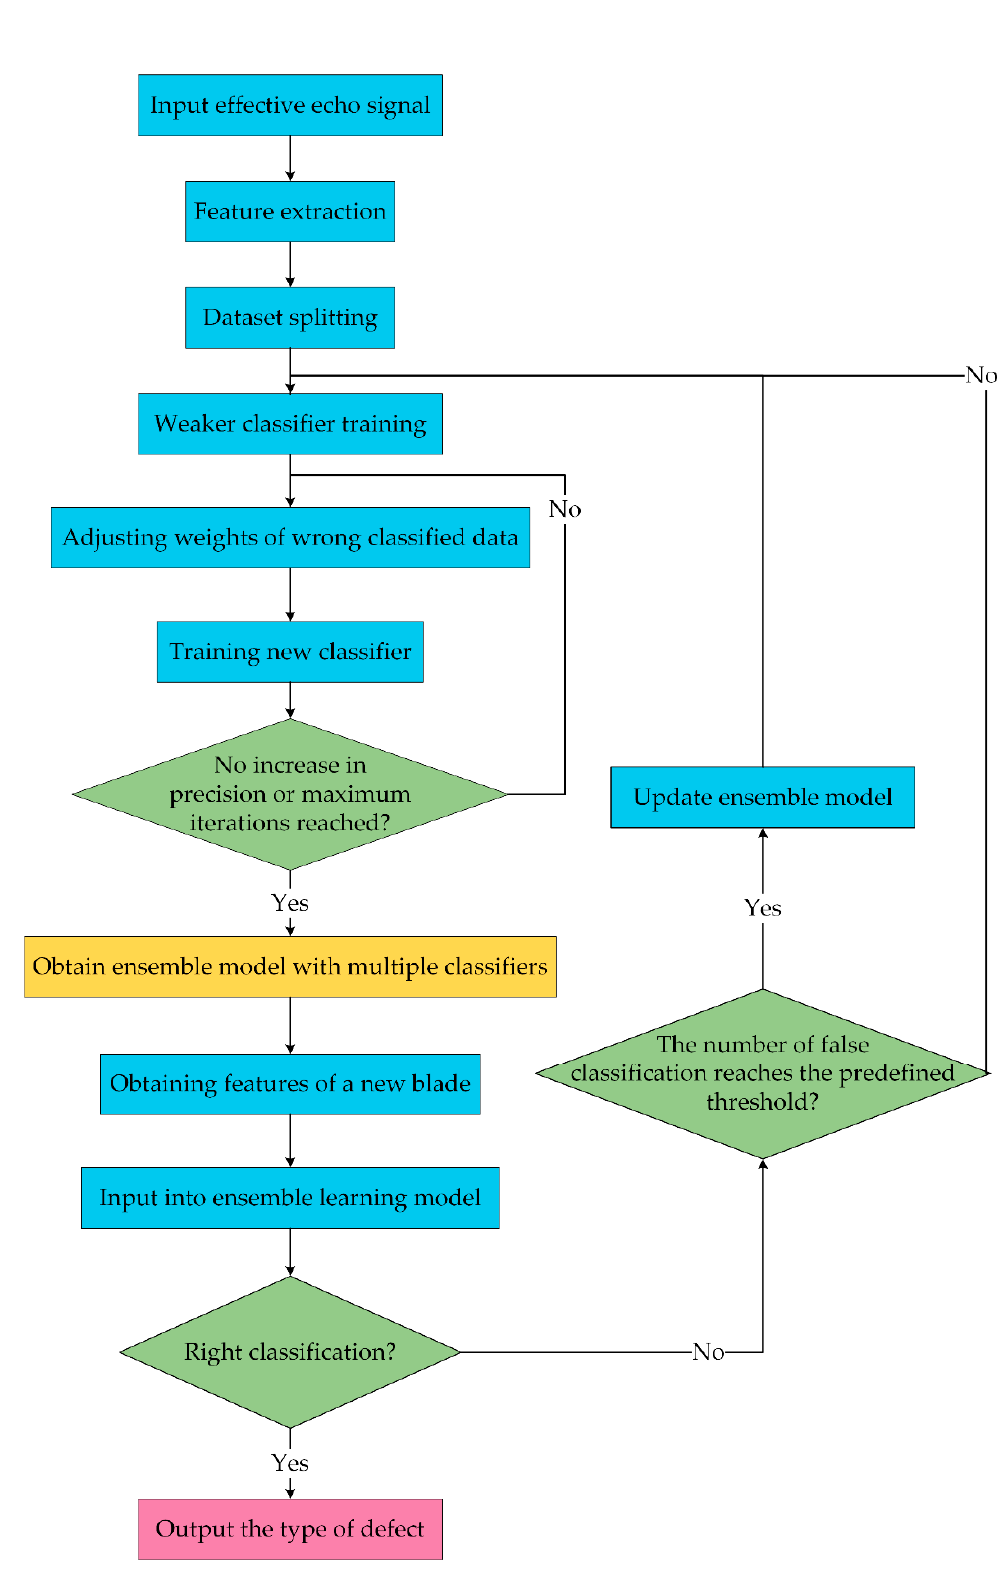
Figure 7. Block diagram of defect identification.